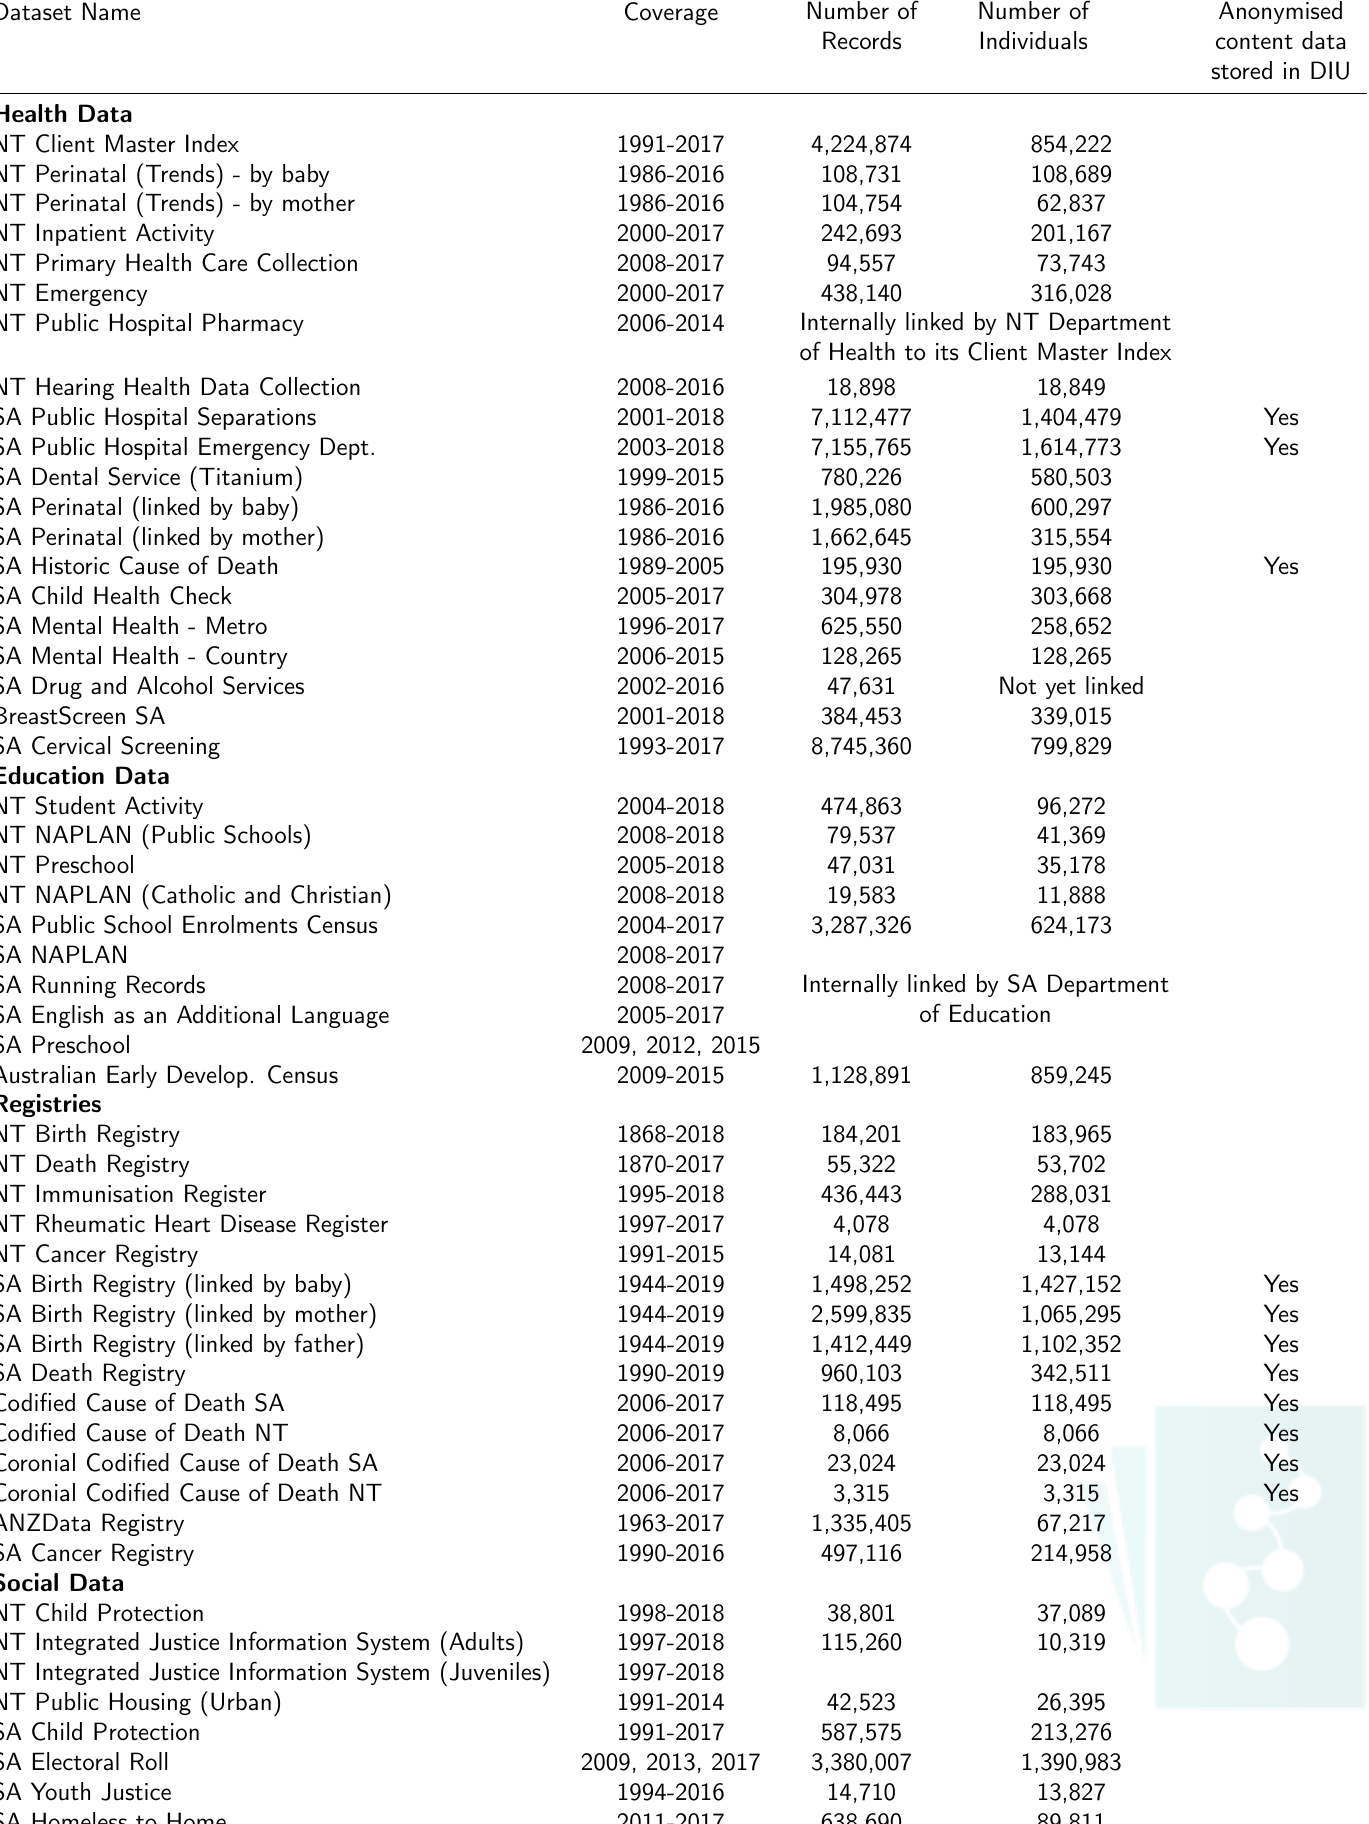
Table 1: Names, temporal coverage and record counts for data sources available in the DLU and DIU (source: SA NT